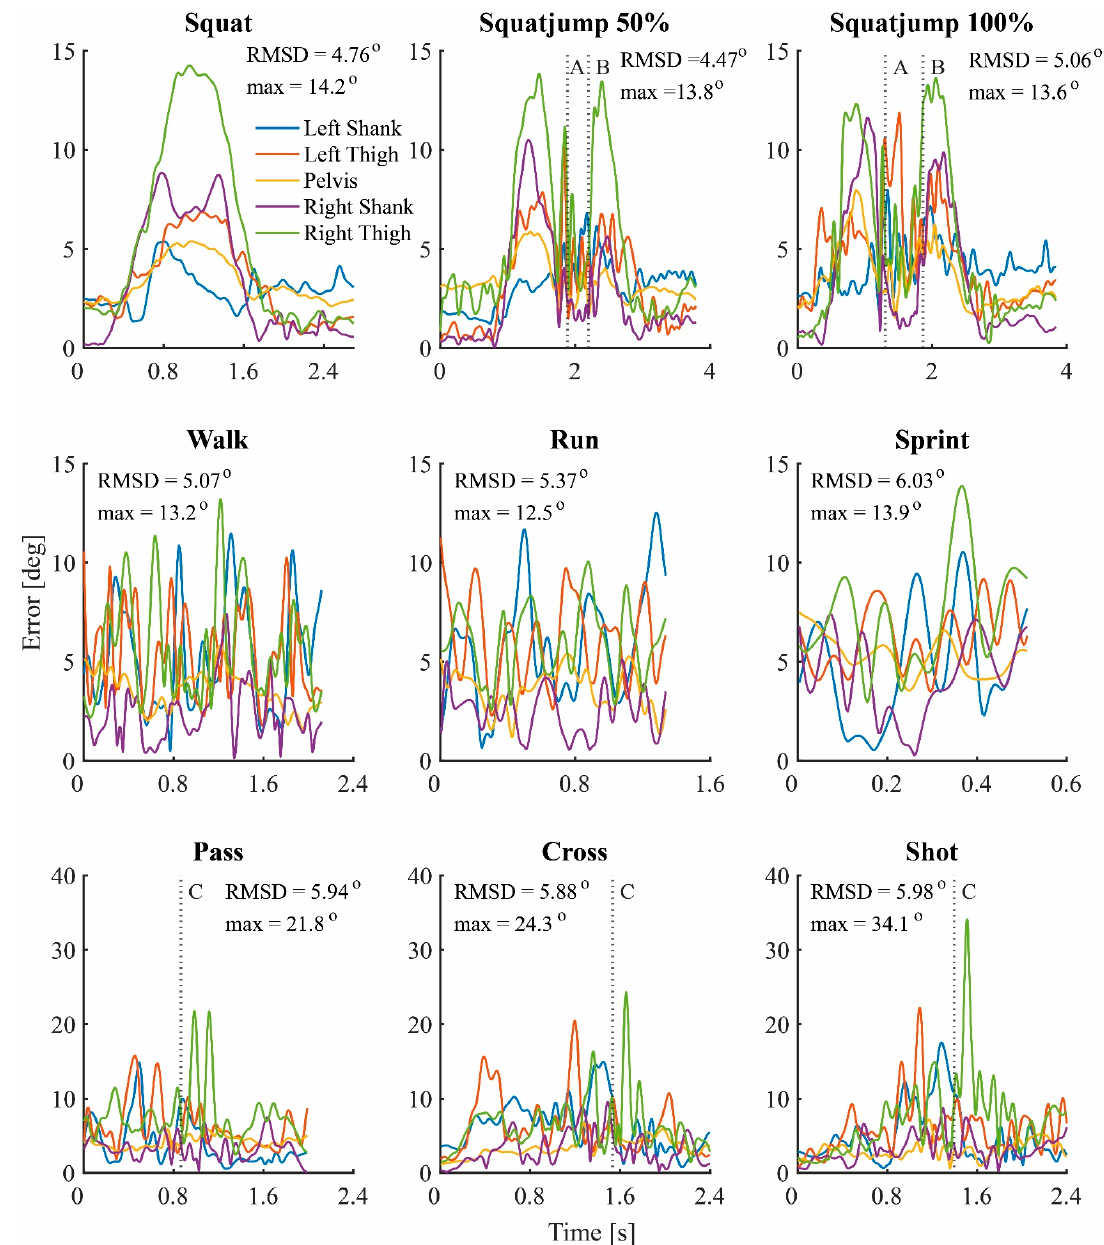
Figure 5. Error caused by the soft tissue artefact, plotted for each trial over time of a typical subject. In the top right corner of each plot the root-mean-square difference (RMSD) across all body segments and maximum error are displayed in degrees. The vertical dashed line represents a specific moment in time: A = push off, B = landing, C = ball contact.